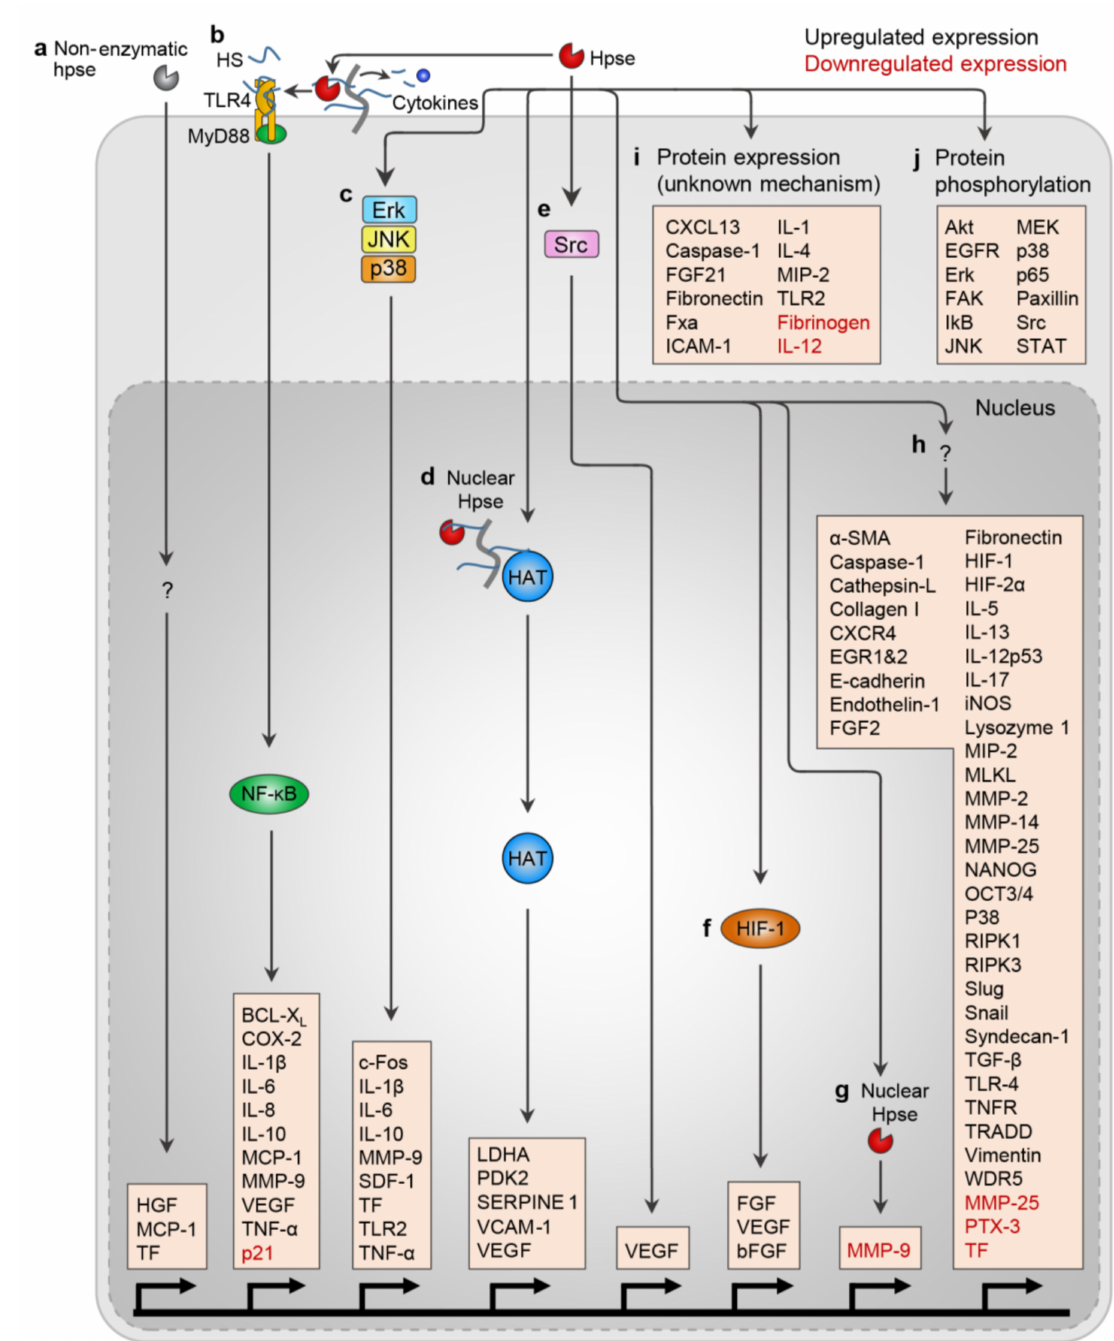
Figure 2. Heparanase regulates protein expression and phosphorylation via multiple mechanisms. Heparanase regulates gene transcription via ( a ) non-enzymatic mechanisms, ( b ) generating soluble HS fragments which bind and activate TLR4 signaling and NF- κ B activation, ( c ) Erk, p38, and JNK signaling, ( d ) nuclear localization and cleavage of HS to activate histone acetyltransferase (HAT), ( e ) Src, ( f ) hypoxia inducible factor (HIF)-1 activation, ( g ) direct binding to promoter to block gene transcription, and ( h ) by unknown mechanisms. ( i ) Heparanase can also regulate the expression of other proteins, although the mechanism of this is unknown. ( j ) Finally, heparanase can induce phosphorylation of several proteins. Hpse, heparanase; HS, heparan